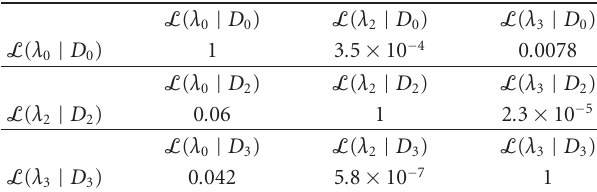
Table 7: The likelihood ratio: Λ CDM + sz + lens + run.